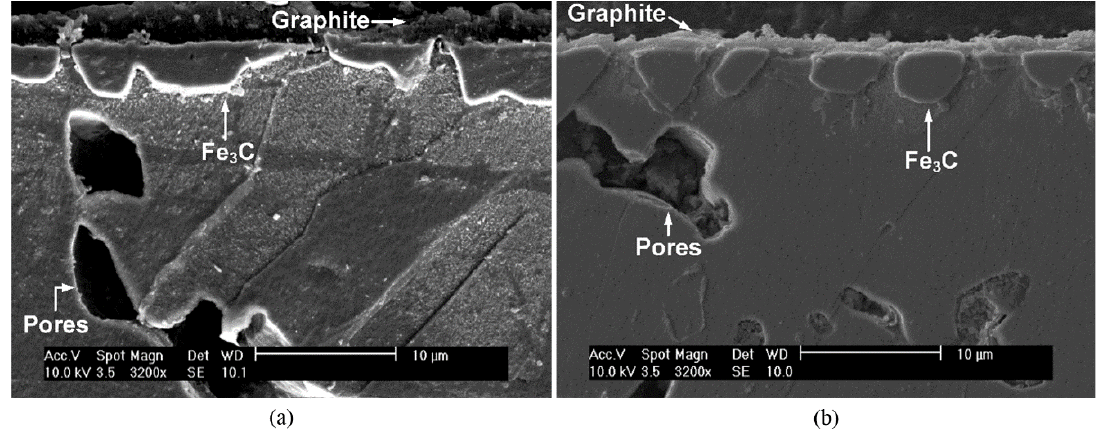
Figure 6. Cross-sectional micrographs of samples carburized at 700 °C: (a) 5% CH